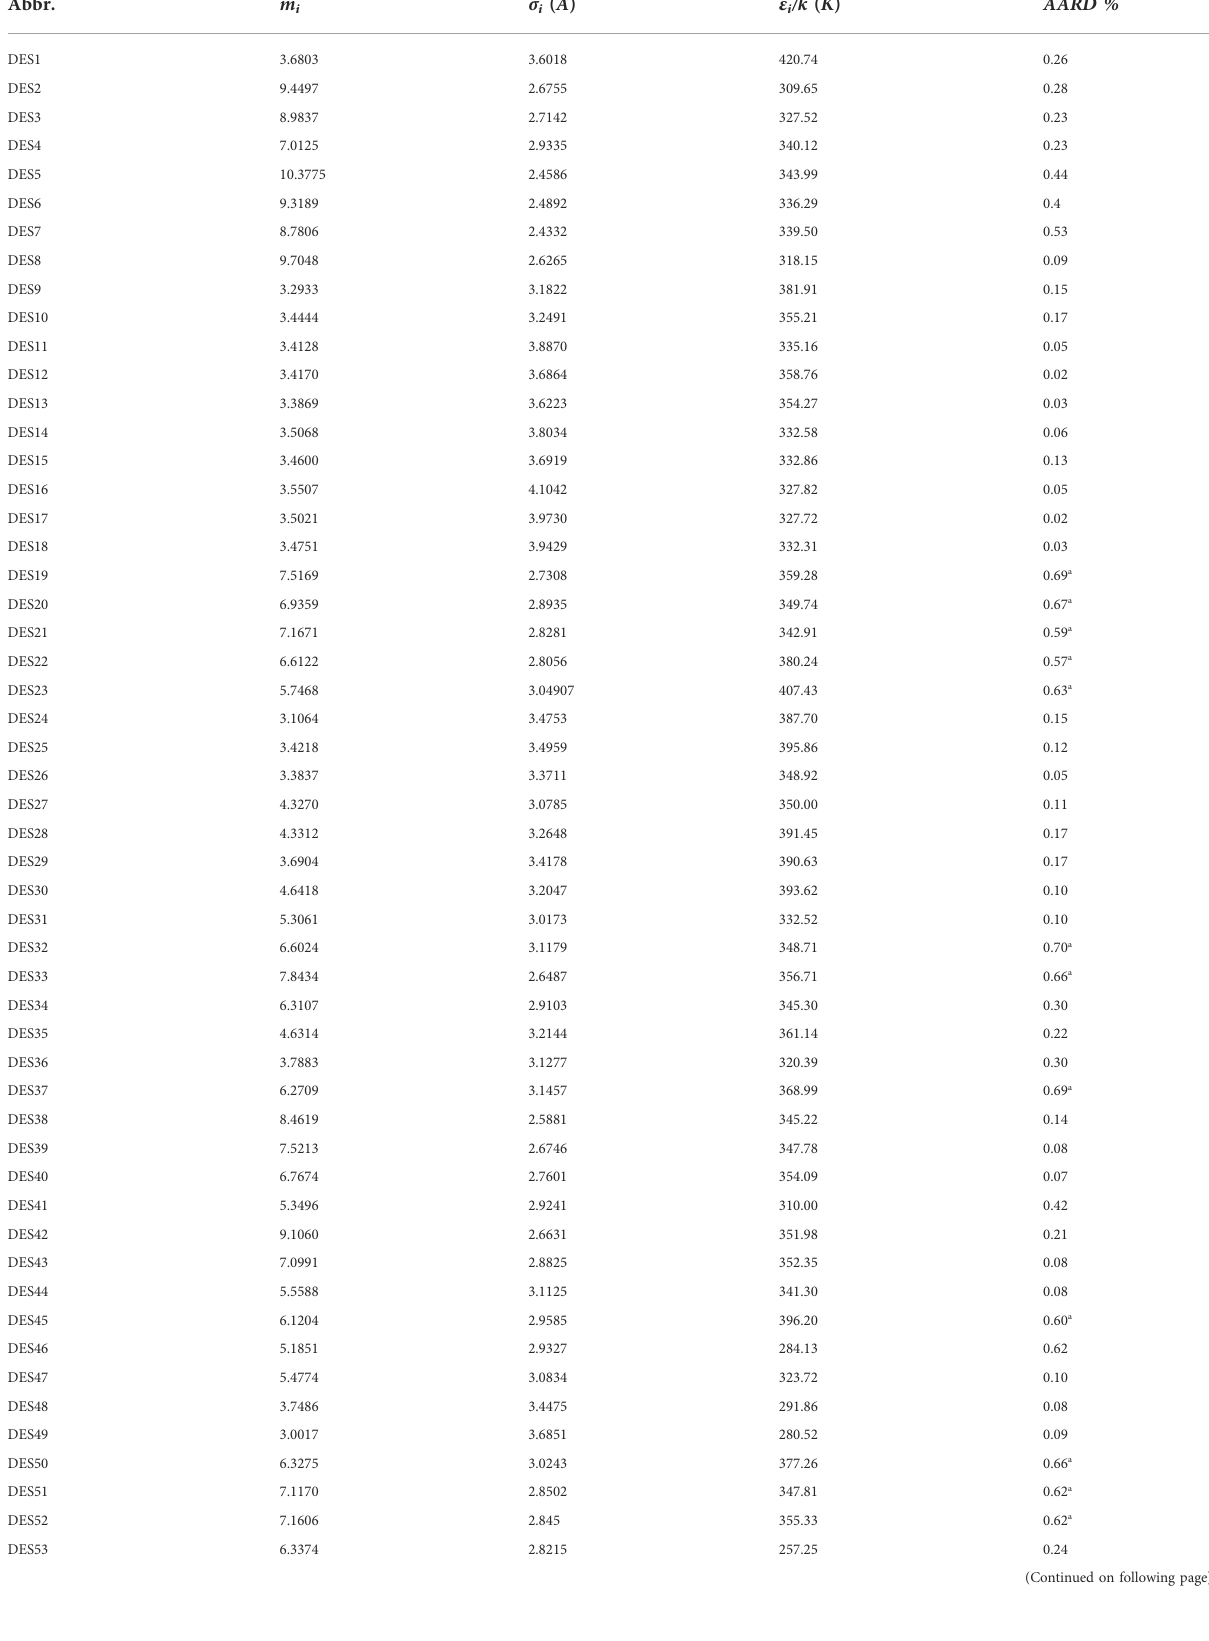
TABLE 1 The values of optimized PC-SAFT parameters for the investigated DESs in this study and carbon dioxide b .